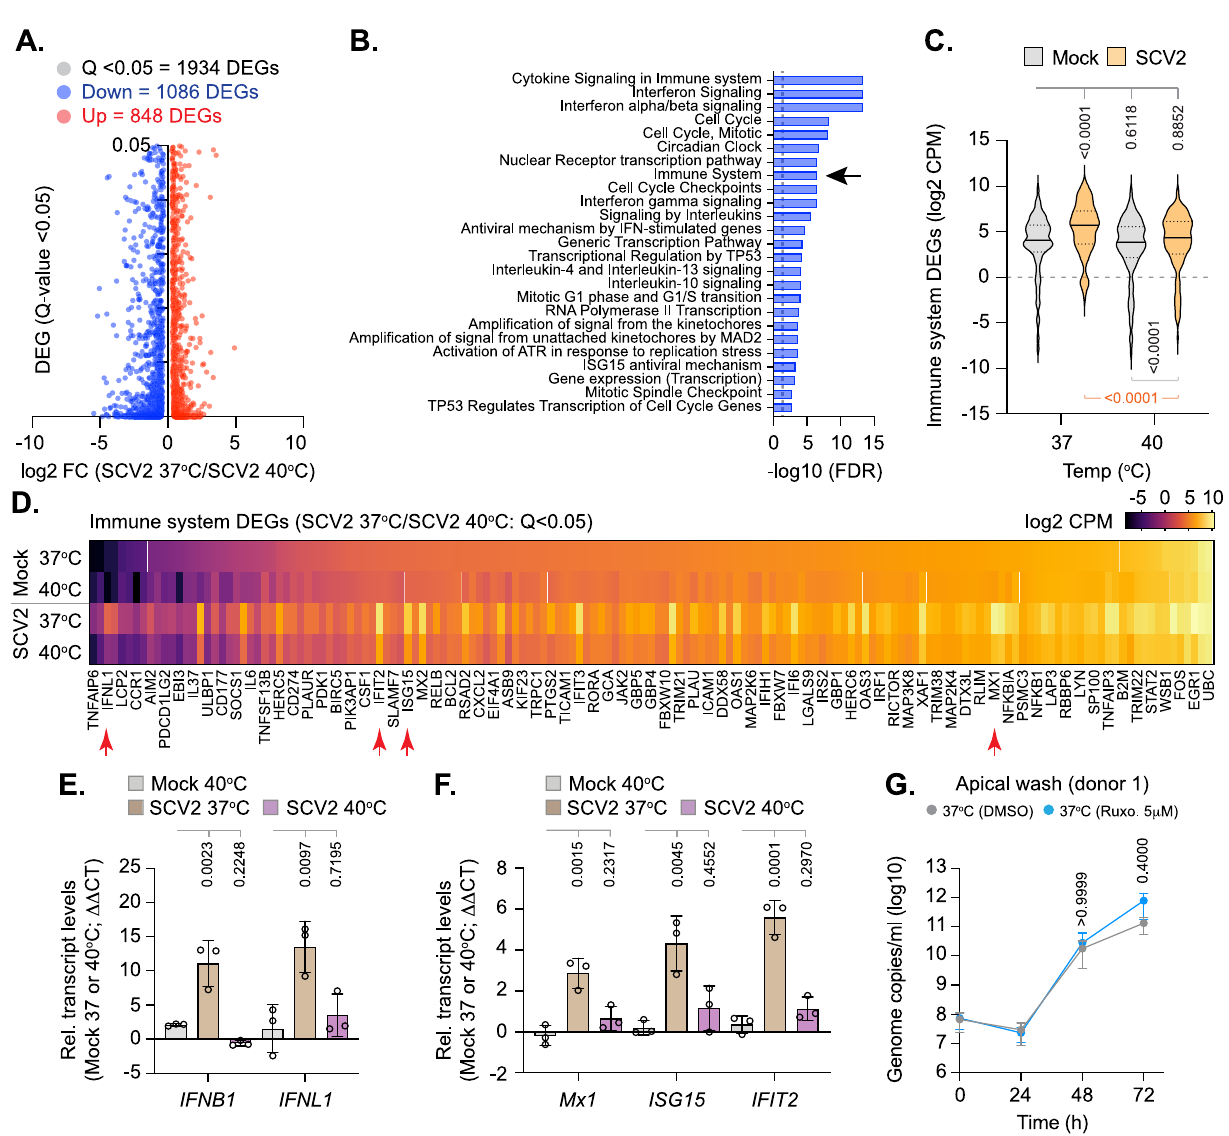
Fig 6. Elevated temperature restricts SARS-CoV-2 replication in respiratory airway cultures independently of IFN-mediated antiviral immune defenses. Ciliated respiratory cultures differentiated from primary HBEp cells isolated from 3 independent donors (donor 1, male Caucasian aged 63 years; donor 2, Hispanic male aged 62 years; donor 3, Caucasian female aged 16 years; all nonsmokers) were incubated at 37 or 40˚C for 24 h prior to mock (media) or SARS-CoV-2 (SCV2; MOI 0.05, 10 4 PFU/Tissue) infection. Tissues were incubated at their respective temperatures for 72 h prior to RNA extraction and RNA-Seq or RT-qPCR. (A) Scatter plots showing high confidence (Q < 0.05) DEG transcripts identified between SARS-CoV-2– infected respiratory cultures at 37 or 40˚C; up-regulated DEGs, red circles; down-regulated DEGs, blue circles. (B) Reactome pathway analysis of mapped down-regulated DEGs. Top 25 down-regulated (FDR < 0.05) pathways shown (blue bars; plotted as − log10 FDR). Dotted line, threshold of significance ( − log10 FDR of 0.05). (C) Expression profile (log2 CPM) of down-regulated immune system DEGs (R-HSA168256; arrow in B) relative to expression levels in mock tissue at 37 or 40˚C. Black line, median; dotted lines, fifth and 95th percentile range; p -values shown, one-way ANOVA (top), paired two- tailed t test (bottom). (D) Expression levels (log2 CPM) of immune system DEGs (identified in B, black arrow) relative to mock at 37 or 40˚C. Every second gene labeled. Red arrows highlight genes chosen for RT-qPCR validation. (A to D) RNA-Seq data derived from RNA isolated from 3 donors (donors 1 to 3) per sample condition derived from 3 independent experiments per donor. (E/F) RT-qPCR ( ΔΔ CT) quantitation of IFN ( IFNB1 and IFNL1 ) or ISG ( Mx1 , ISG15 , and IFIT2 ) transcript levels within mock or SARS-CoV-2–infected respiratory cultures derived from 3 independent donors (transcript values normalized to GAPDH per sample condition). N � 3 tissues per donor per condition derived from 3 independent biological experiments. Means and SD shown; all data points shown; p -values shown, one-way ANOVA. Individual Δ CT values per donor are shown in S6 Fig for donor comparison. (G) Respiratory cultures differentiated from donor 1 HBEp cells were pretreated with Ruxo (5 μ M) or carrier control (DMSO) for 16 h prior to SARS-CoV-2 infection (MOI 0.05, 10 4 PFU/Tissue) and continued incubation at 37˚C in the presence of inhibitor or carrier control. Apical washes were collected at the indicated times (h) and genome copies per ml determined RT-qPCR. N = 3 tissues per sample condition derived from 3 independent biological experiments. Means and SD shown; p -values shown, Mann–Whitney U test. Raw values presented in S8 and S9 Data. CPM,